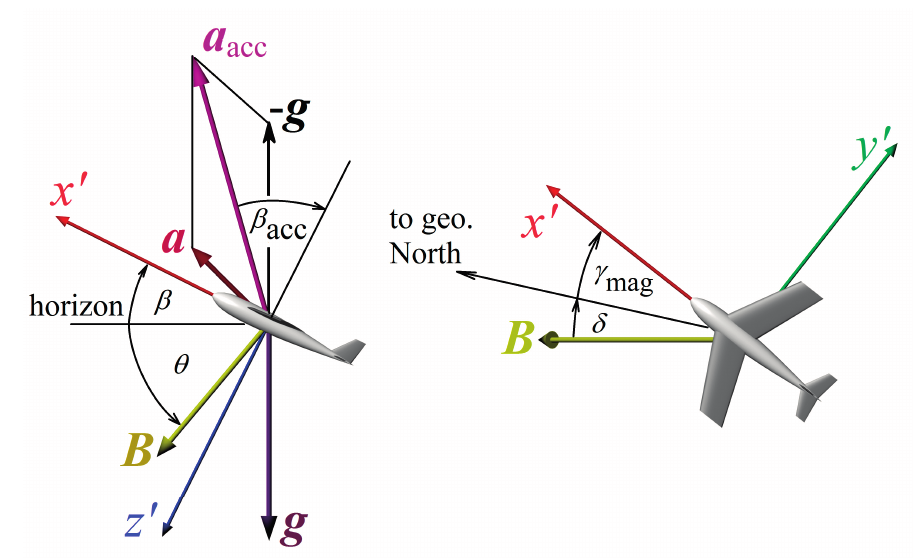
Figure 13. Accelerometer and magnetic compass readings at non-zero pitch β and yaw γ . Acceleration a acc is measured by the on-board accelerometer as a sum of the gravity acceleration g and object’s acceleration a . Earth’s magnetic field induction B has inclination θ , declination δ and its horizontal complement points to magnetic North.